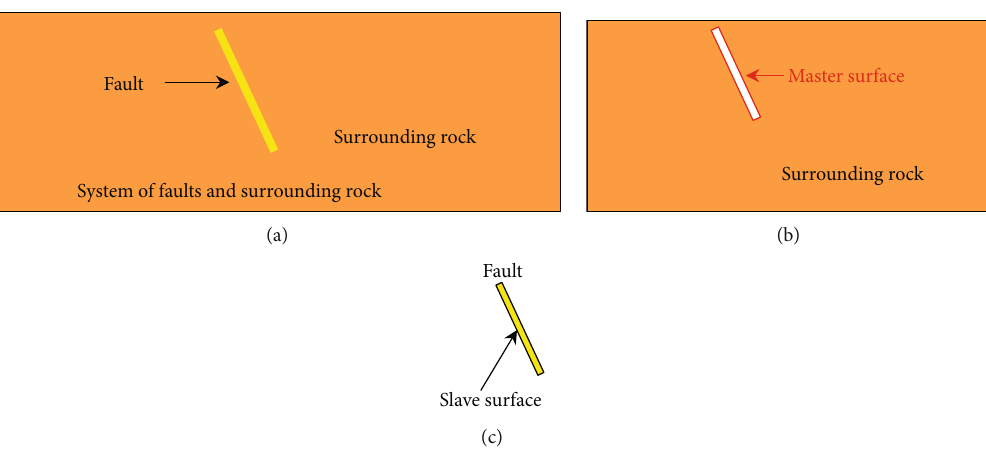
Figure 4: The master-slave surfaces of fault and its surrounding